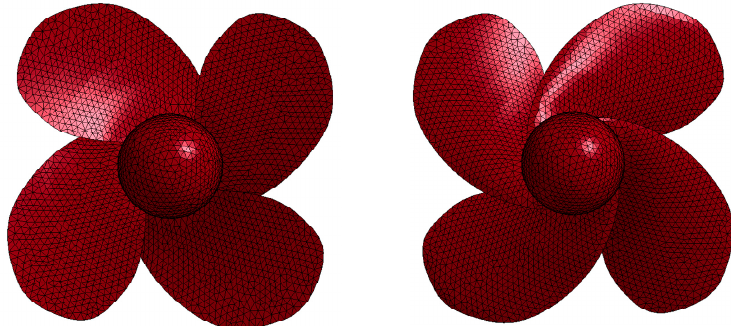
Figure 4. The numerical model of ice block impacting propeller.